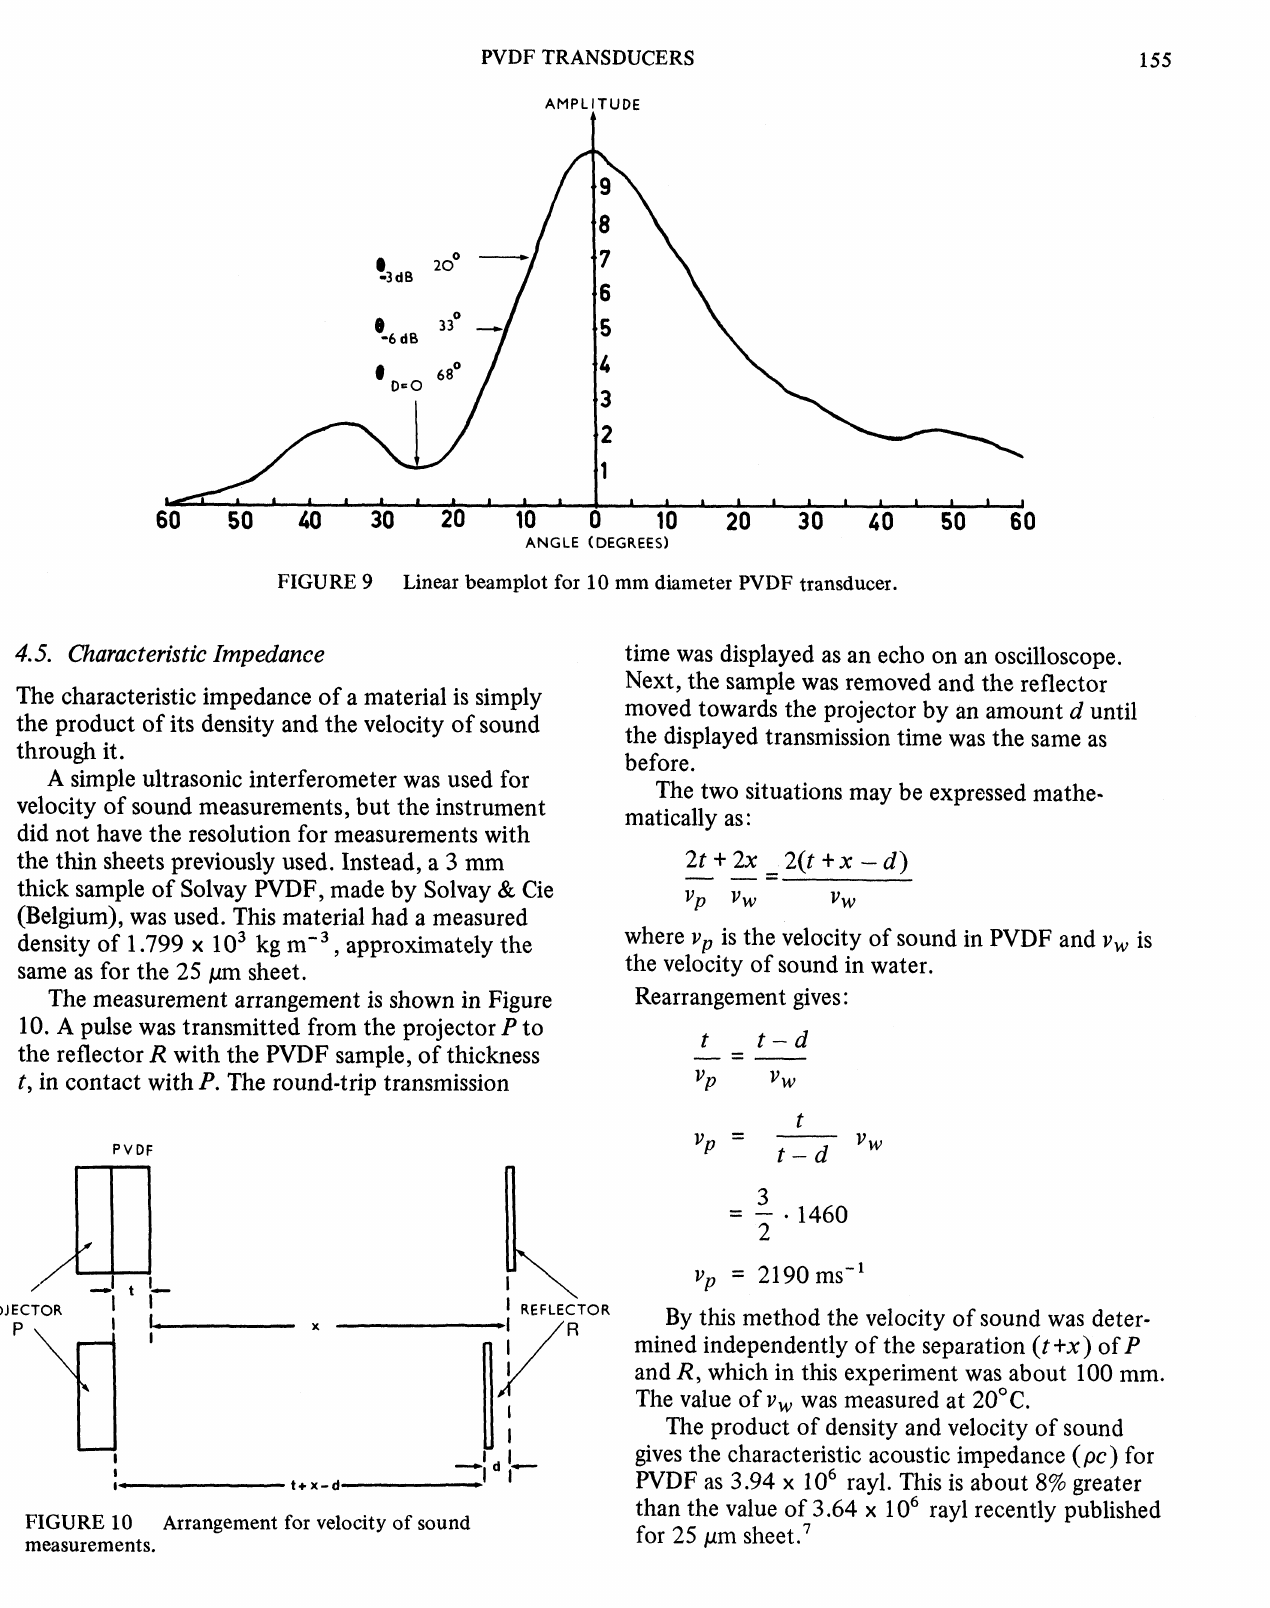
t/x-d FIGURE 10 Arrangement for velocity of measurements.